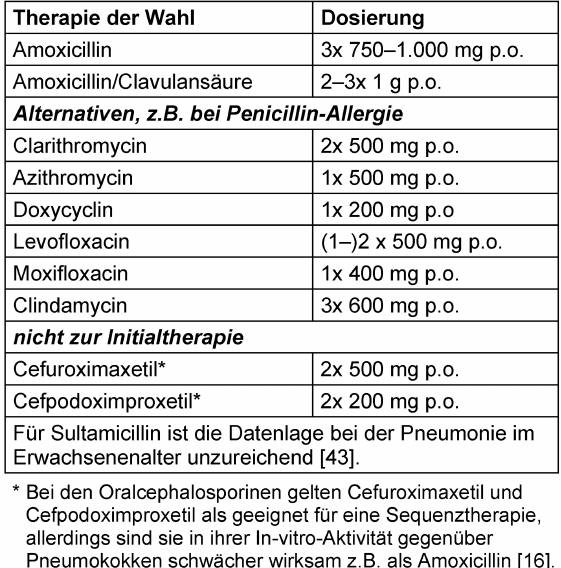
Tabelle 5: Orale Sequenztherapie bei Patienten mit erreich- ter klinischer Stabilität und ohne Erregernachweis bei CAP (bei Erregernachweis: gezielte Therapie siehe Tabelle